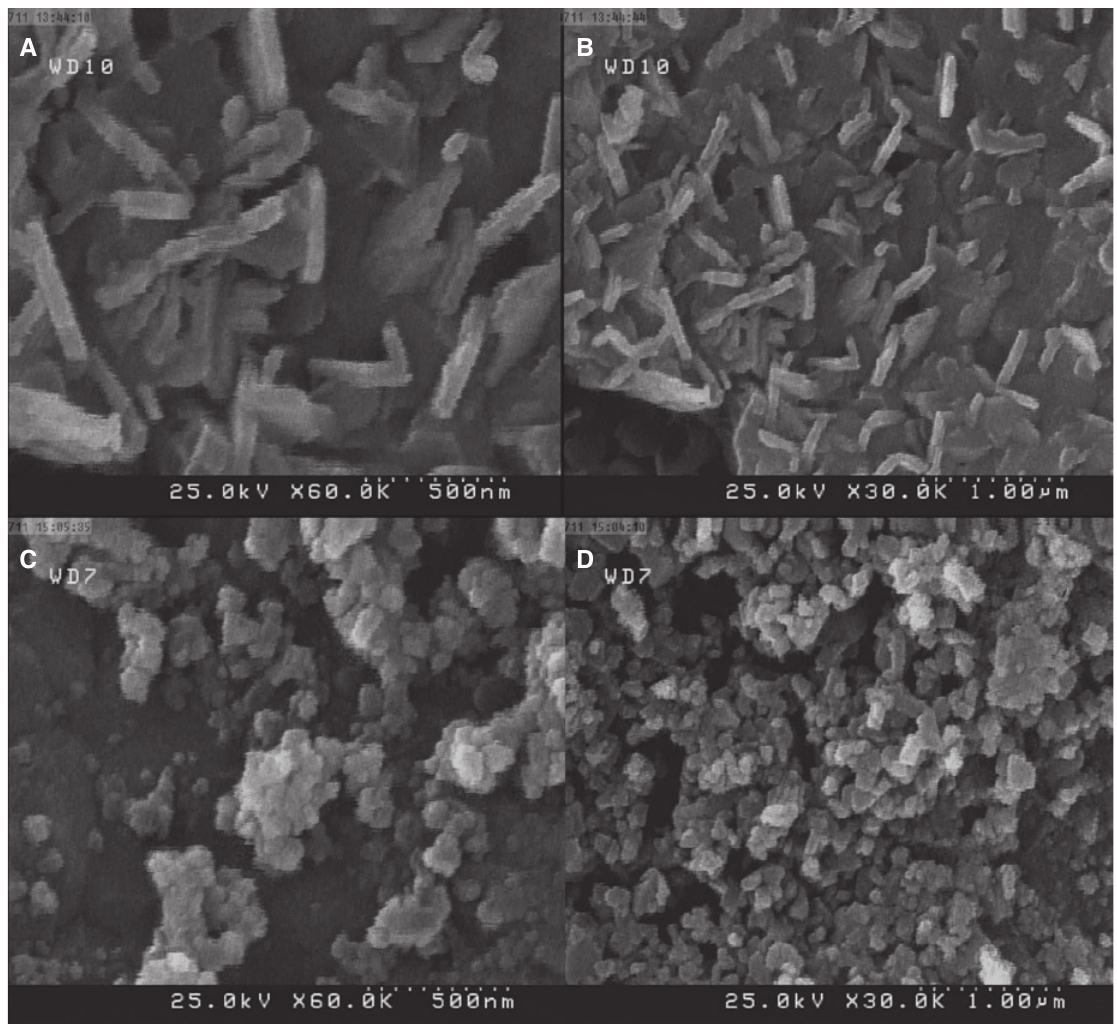
Figure 4: SEM images of SrFe with citric acid at (A, B) 700 ° C and (C, D) 500 °